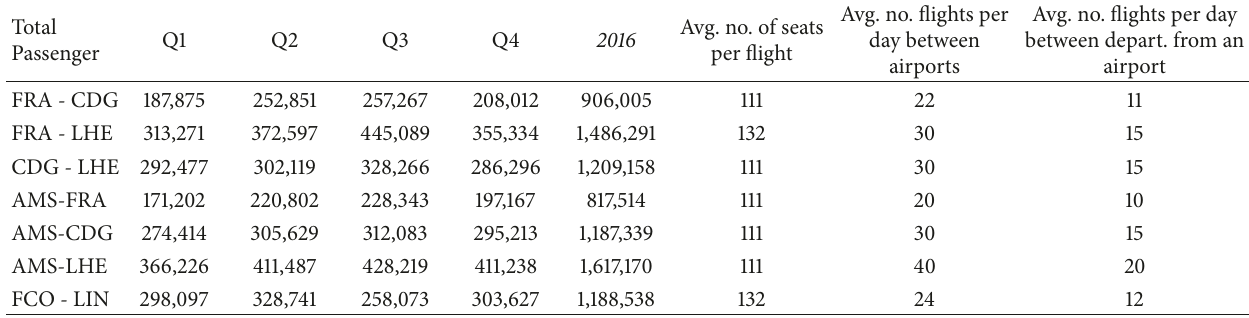
Table 6: Passengers per route [18].